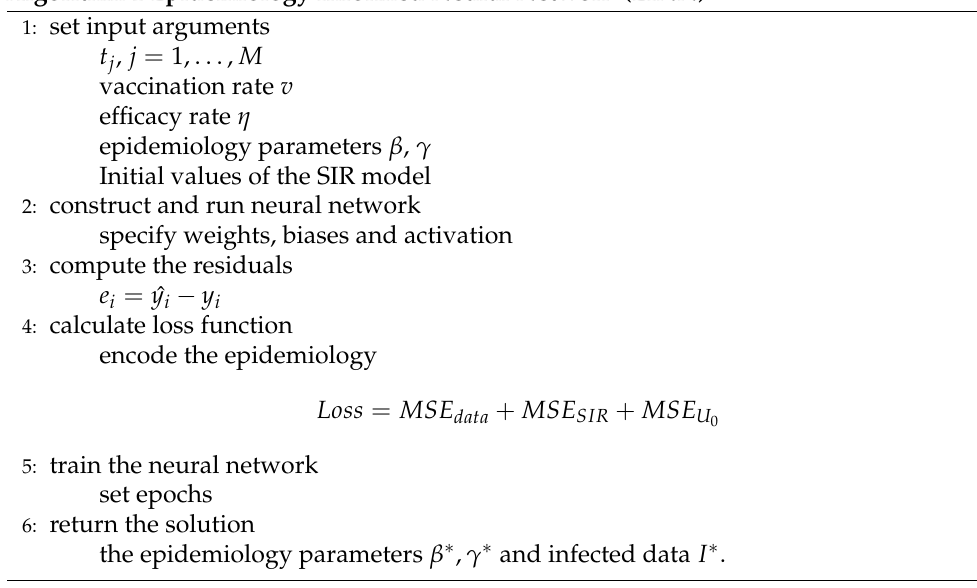
Algorithm 1 Epidemiology Informed Neural Network